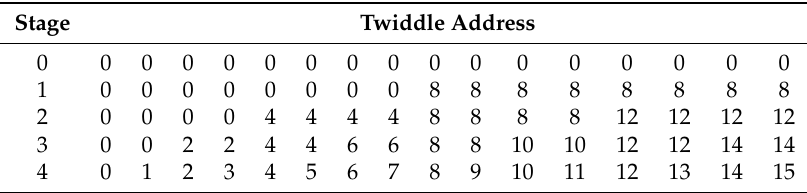
Table 1. Phase factor addressing scheme example ( N = 32 and β =